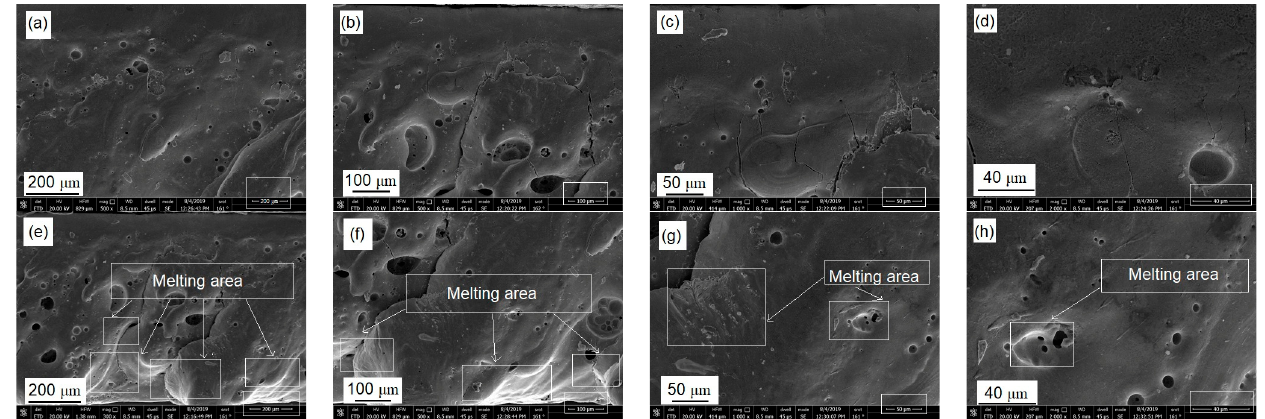
Figure 16. ( a – h ) Cross sections of the cutting area in SEM images: ( a – d ) pre-PAC; ( e – h ) post-PAC.